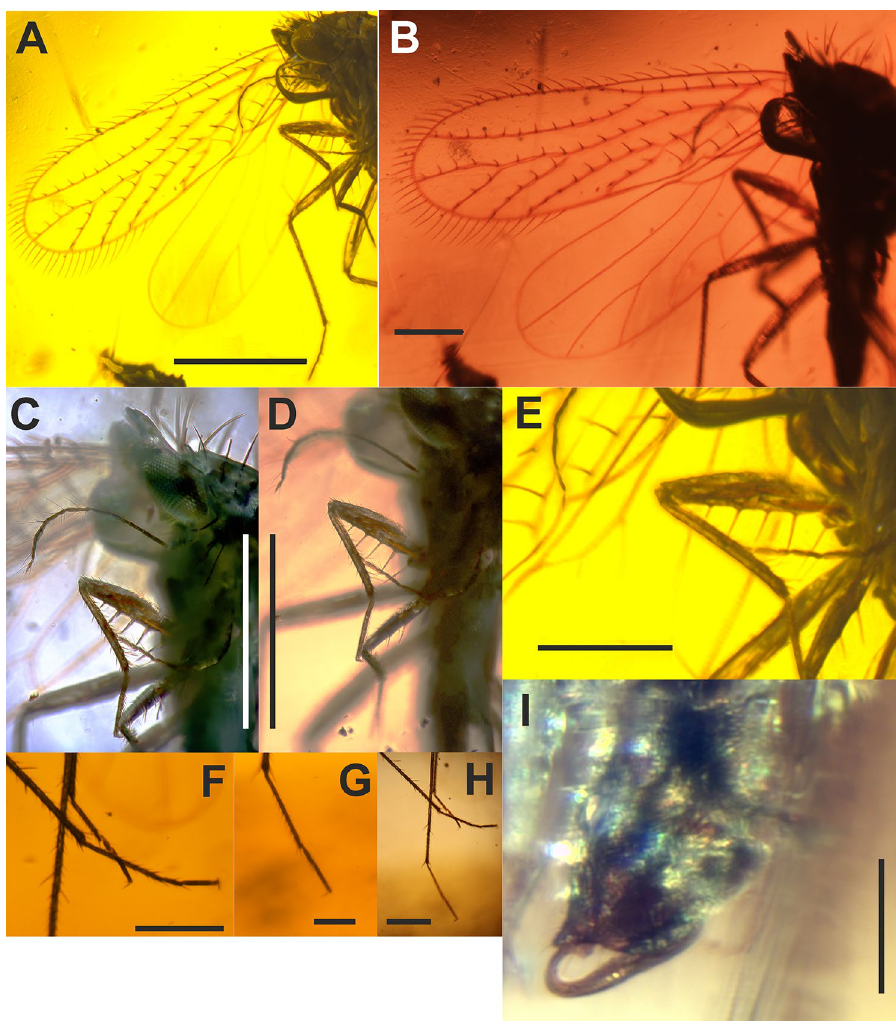
Figure 2. Megalophthallidion burmapteron gen. et sp. nov., holotype (MAIG 6687), imago. ( A ) Photo of right fore wing; ( B ) photo of right wings; ( C ) photo of antenna and proleg; ( D ) photo of proleg and mesoleg, and ( E ) photo of femur of proleg, and ( F ) photo of right metatarsus and left mesotarsus in the background, and ( G ) photo of right mesotarsus of mesoleg, and ( H ) Photo of tarsi; ( I ) photo of male genital block. Scale bars: 0.5 mm ( A–D ), 0.2 mm ( B,E,F,H ), 0.1 mm ( G,I